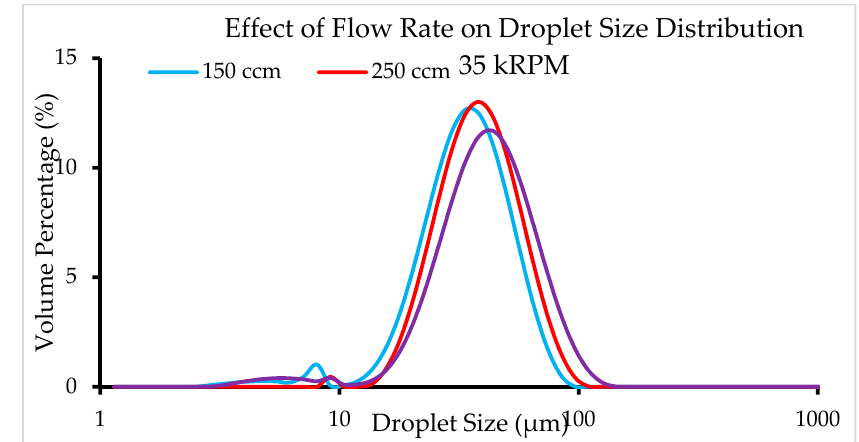
Figure 11. Droplet size distribution at a fixed rotational speed of 35 kRPM.